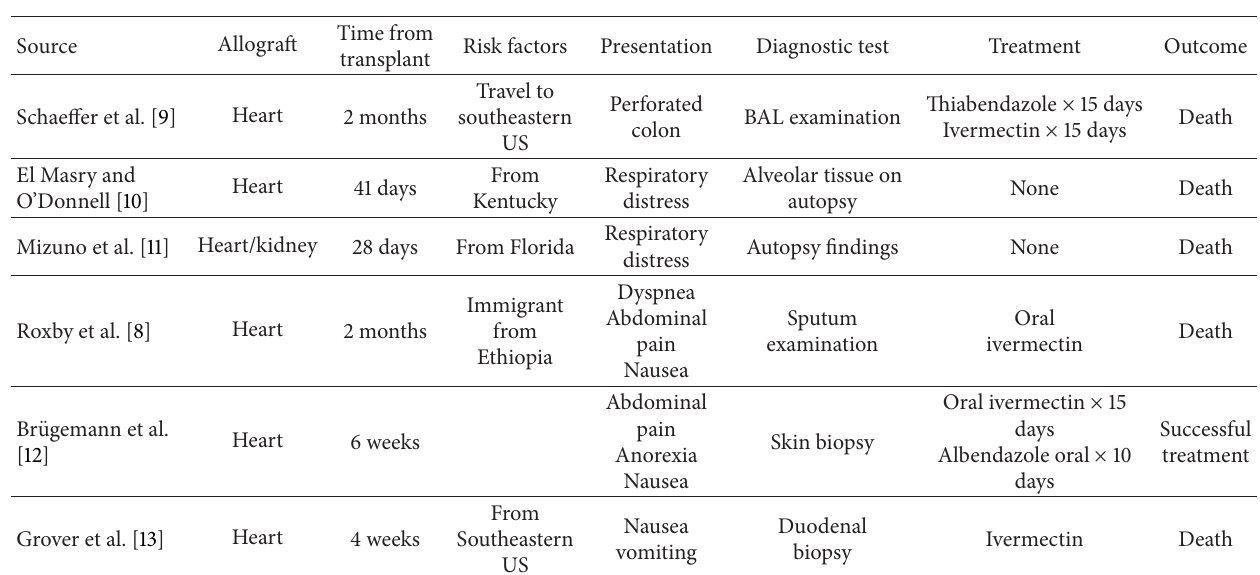
Table 2: Strongyloidiasis in cardiac